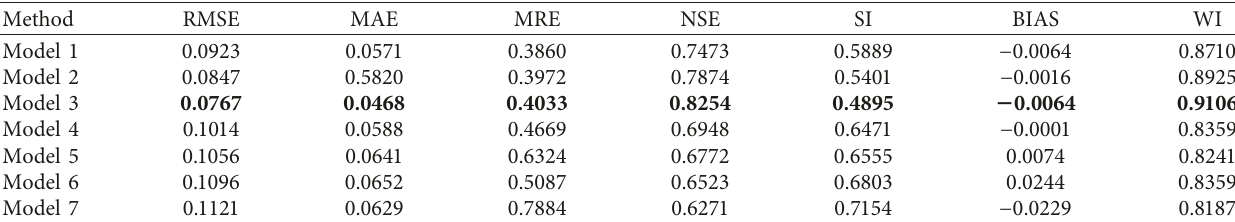
Table 8: The numerical evaluation indicators for the GA-SVR predictive model over the testing modeling phase.